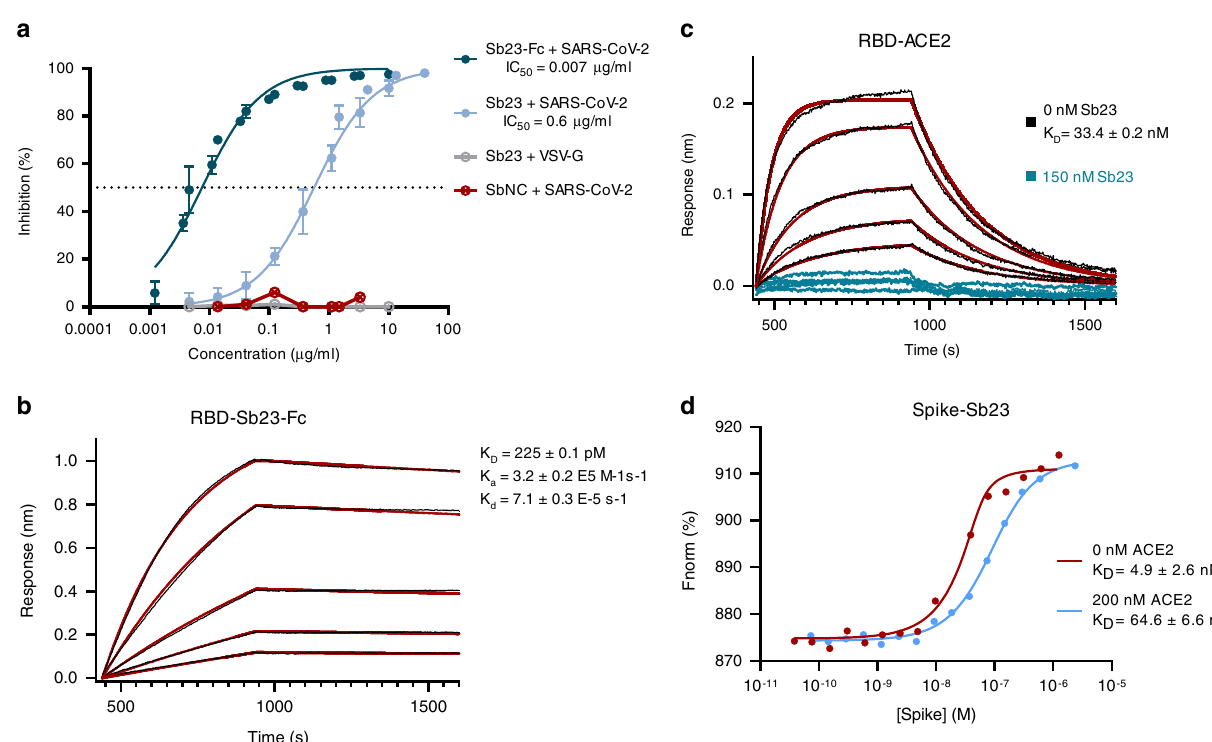
Fig. 3 Sb23 neutralizes SARS-CoV-2 pseudoviruses and competes with ACE2. a SARS-CoV-2 or VSV-G spike pseudotyped lentivirus was incubated with a dilution series of Sb23, Sb23-Fc, or a control sybody (speci fi c for hPepT2). Neutralization by Sb23 is a representative of two independent experiments. Data are mean ± SD of six replicate experiments. Neutralization by Sb23-Fc represents two independent assays, performed in duplicates. Data are mean ± SD of two or four replicate experiments. b BLI sensorgrams of immobilized SARS-CoV-2 RBD with 2-fold serial dilution of 20 nM Sb23-Fc. Binding curves are colored black and the global fi t of the data to a 1:1 binding model is red. c BLI sensorgrams of immobilized SARS-CoV-2 RBD with ACE2 in the presence (blue) or absence (black) of 150 nM Sb23. The assay was performed in a concentration range of 200-12.5nM ACE2 and fi t of the data to a 1:1 binding model is shown in red. d Microscale thermophoresis (MST) binding data of spike with fl uorescently labeled Sb23, in the presence or absence of 200 nM ACE2. One representative measurement is shown. Three independent measurements were performed and af fi nities of spike to Sb23 in the absence of ACE2 ranged from 0.6 to 10 nM, while they were signi fi cantly lower in the presence of ACE2 ( K D = 58 – 200